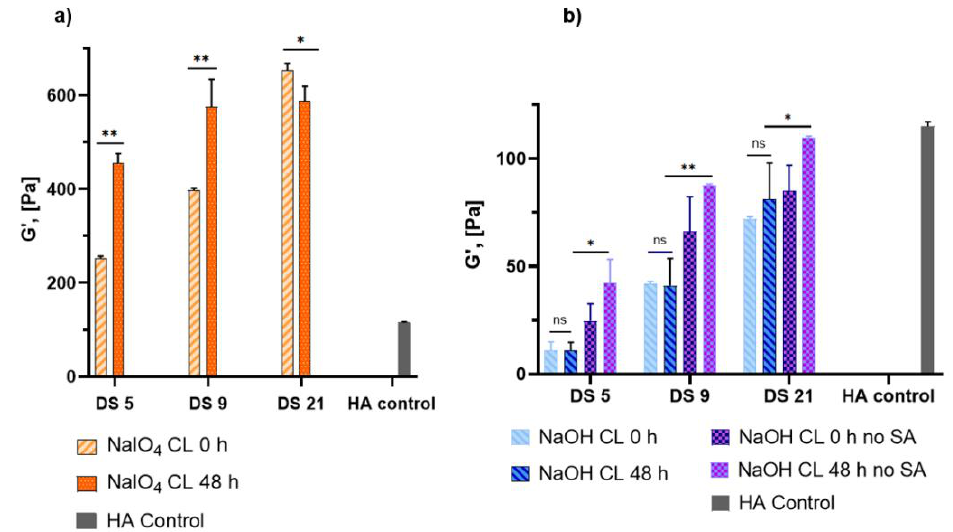
Figure 5. Evolution of the storage modulus ( G′ ) of the NaIO 4 -CL and NaOH-CL gels at 0 and 48 h after crosslinking initiation (oscillation at 1 Hz). ( a ): G′ of NaIO 4 -crosslinked gels at the 3 DS. ( b ): G ′ of NaOH-crosslinked gels with and without addition of SA. Control HA (Belotero Intense ® ) is given as a reference. * p ≤ 0.01; ** p ≤ 0.0001 ; ns: not significant. The G (cid:48) values of the NaIO 4 -CL gels are all above 200 Pa right after crosslinking induction (G (cid:48) 0) and change dramatically 48 h after (G (cid:48) 48). There are no significant changes in G (cid:48) 0 and G (cid:48) 48 for NaOH-CL gels containing SA ( p > 0.98), whatever the DS. In